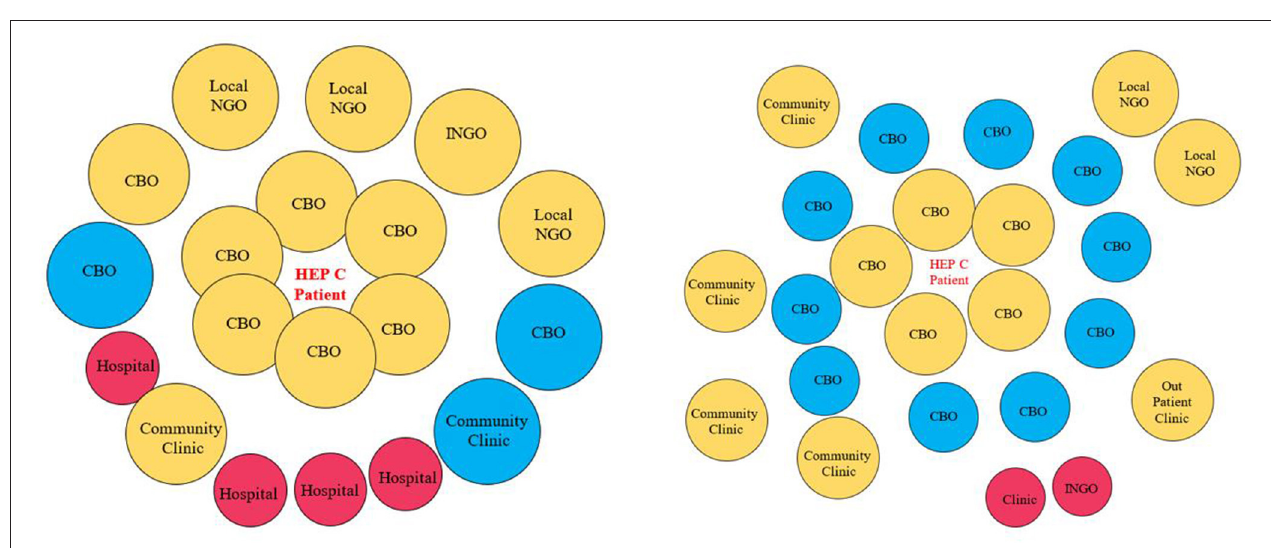
FIGURE 3 | Venn diagrams from NGO-level AG meeting. The circle size implies perceived level of influence from the stakeholder to the center. The distance from the circle to the center point implies access level from the stakeholder to the center. HCWs, Healthcare workers; PLHIV, People living with HIV; CBO, Community Based Organization; INGO, International Non-Government Organization; Local NGO, Local Non-Government Organization.